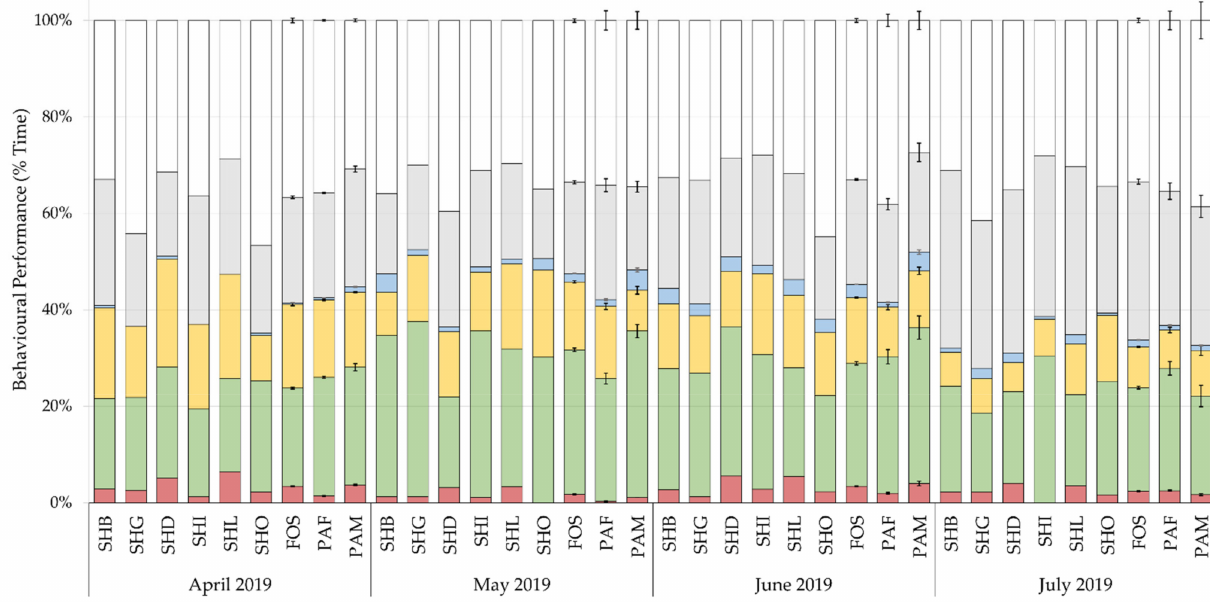
Figure 3. Average monthly time-activity budgets of individual foster-reared chicks, foster-reared chicks as a group (FOS), and grouped female and male parent-reared chicks (PAF and PAM, respectively). White = resting; grey = preening; blue = other; yellow = movement; green = feeding; red = alert. Standard error bars represent variation within parent-reared chicks. Chicks spent most of their time resting, preening, and feeding. Over time, feeding, movement, and vigilance decreased, whereas preening and resting increased. Foster-reared chicks spent less time feeding than parent-reared chicks, overall average time spent feeding 23% and 26%,